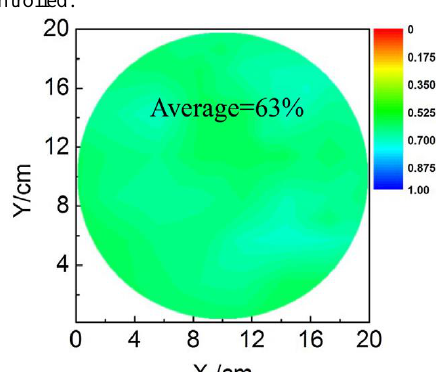
The full-aperture diffraction efficiency is 63%, which is only 1.8% below the theoretical value of 64.8%, as shown in Figure 5. The measured etched depth of each step deviates about 5% from design value. The data imply that the fabrication errors are well controlled.